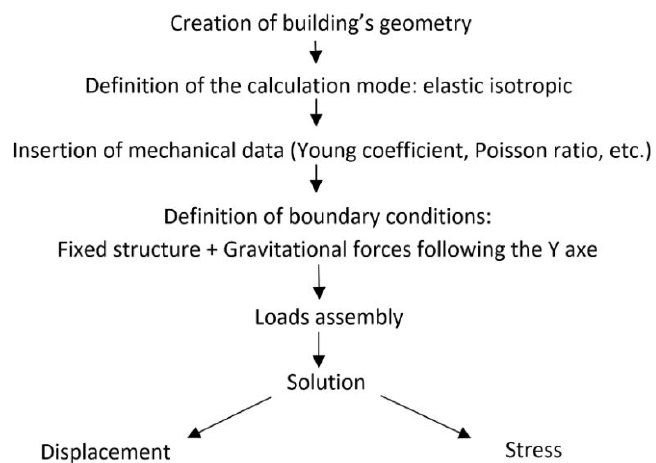
Figure 10. Steps of mechanical equilibrium computation.